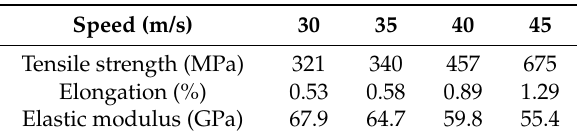
Table 1. Tensile strength, elongation, and elastic modulus of amorphous (TiZr) 0.5 (Ni 0.6 Cr 0.1 V 0.1 ) 2.1 ribbons at different spinning speeds.